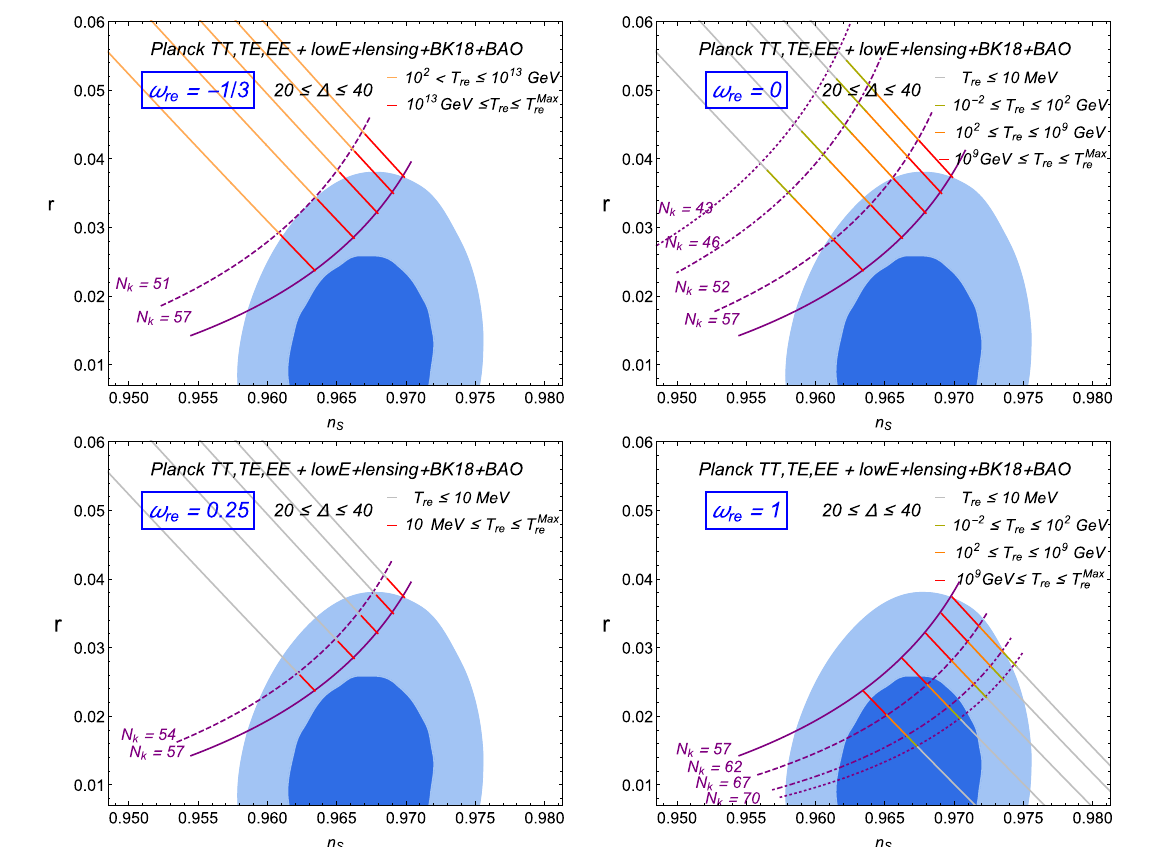
Fig. 4 The n S − r plot for natural inflation with potential given in Eq. (22). The shaded regions are the same as Fig.